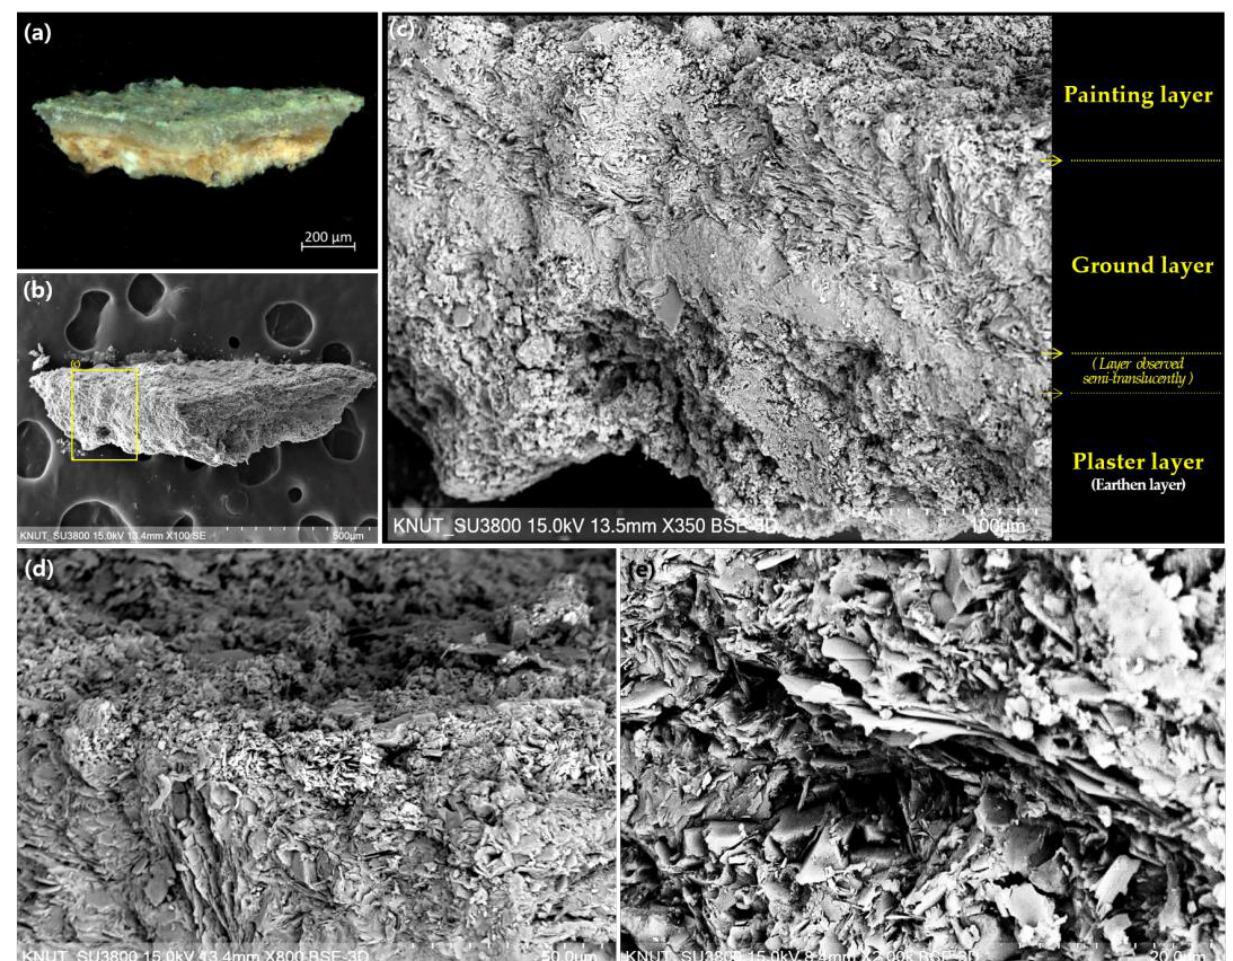
6 of 13 Figure 6. Sample details of mural sample. ( a ) front details: red-brown clay materials and white con- taminants, ( b ) front details: status of pigment in painting layer, ( c ) back details: Mixture of lime with materials presumed to be fiber, charcoal, etc. 3.2.2. Scanning Electron Microscopy (SEM) with Energy Dispersive Spectroscopy (EDS) Then, we observed and analyzed each layer of the Jinpari Tomb No. 4 sample. An analysis of the painting layer and the ground layer showed clear difference in particle shapes between the two layers (Figure 7). The painting layer showed needle-shape struc- tures aggregated in spherical shapes (Figure 7d). The ground layer consists of layers of panel-shaped particles (Figure 7e). A chemical composition analysis of each layer identi- fied the main components of the painting layer as Ca, Cu, K, and Fe, suggesting the use of green pigment containing copper (Figure 8a). The main component materials of the ground layer were Ca, Al, Si, K, Mg, and Fe, which are usually found in earthen materials (Figure 8b). The semitransparent layer beneath the ground layer posed more difficulties in identifying structural characteristics and showed a high Ca content (Figure 8c). Similar characteristics were identified in the sample mapping results (Figure 9). The mapping